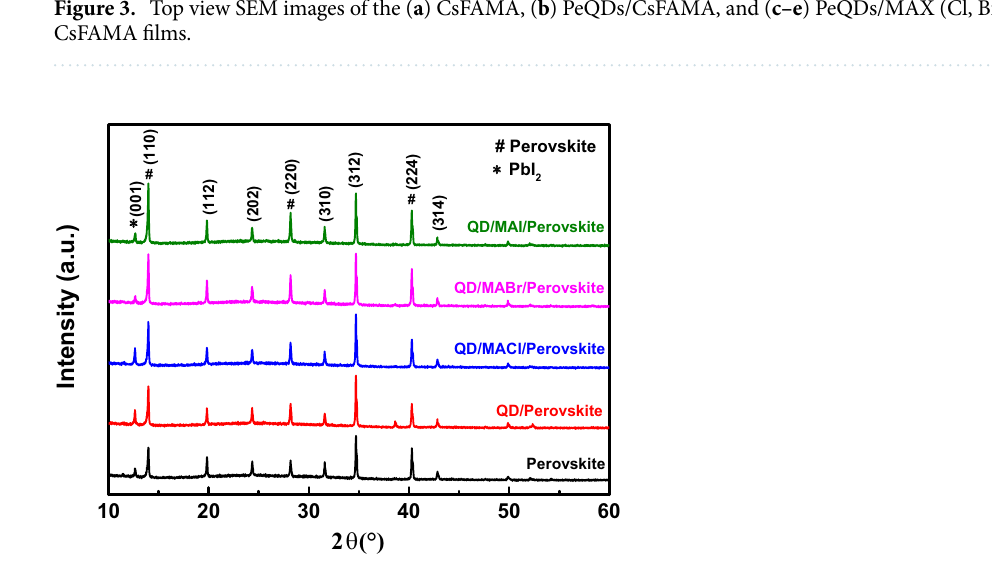
Figure 4. X-ray diffraction (XRD) patterns of the CsFAMA, PeQDs/CsFAMA, and PeQDs/MAX (Cl, Br, I)/ CsFAMA